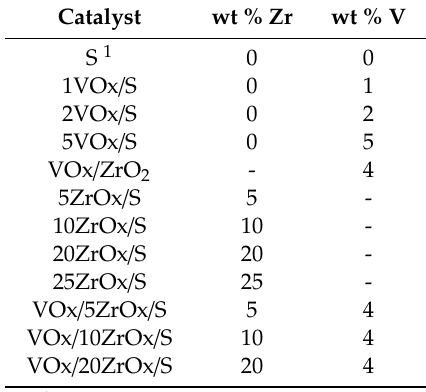
Table 4. V and Zr loadings in synthesized